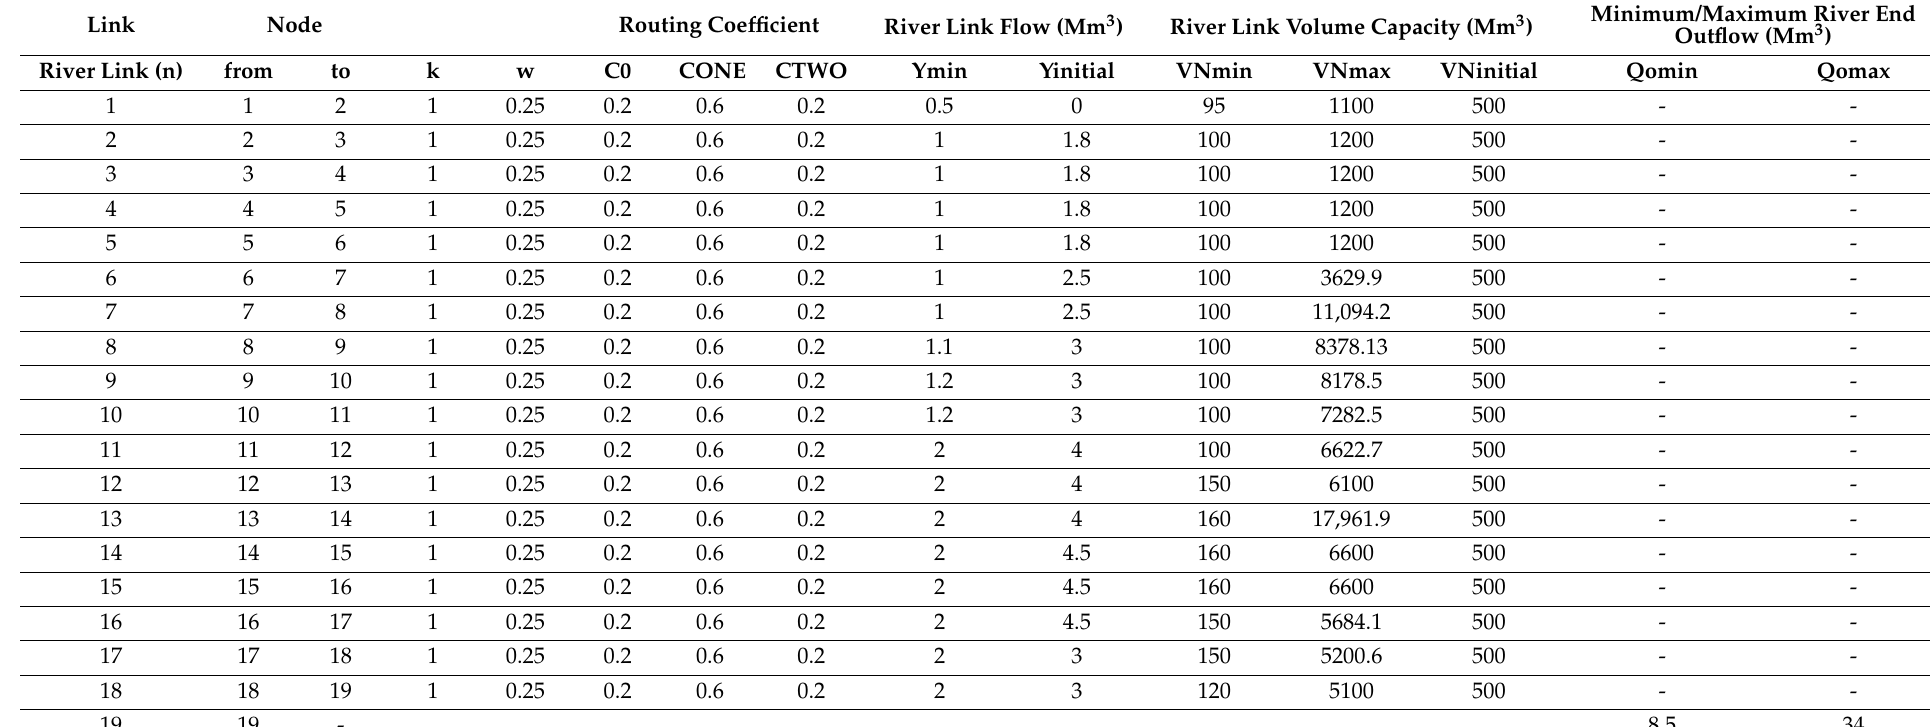
Table 6. Input data used in the model for river link part constraints.